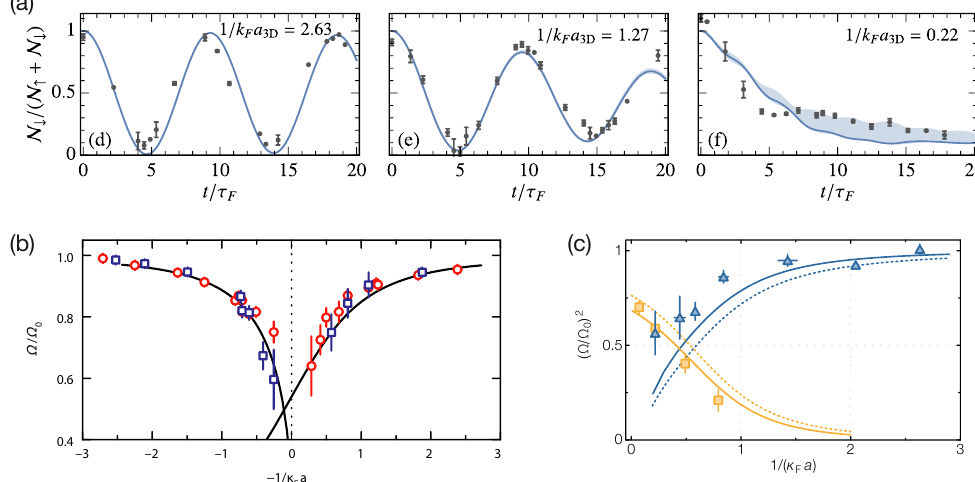
Figure 5. Rabi oscillations between non-interacting and strongly interacting impurity states in a fermionic medium. ( a ) Points are experimental measurements, while lines denote theoretical predictions based on a variational ansatz with no free parameters [28]. Shaded regions allow for experimental parameter uncertainties. ( b , c ) Normalized Rabi frequency extracted from experimental Rabi oscillations (symbols) in mass-imbalanced [in (b)] [16] and equal-mass [in ( c )] [23] mixtures are √ Z [in ( b )] and Z [in ( c )] (lines), obtained with a T -matrix compared to theoretical predictions for method [16,23,77]. Solid lines in panel ( c ) take into account the effect of small initial-state interactions. Panel ( a ) is adapted from Ref. [28], panel ( b ) from Ref. [16], and panel ( c ) from Ref.